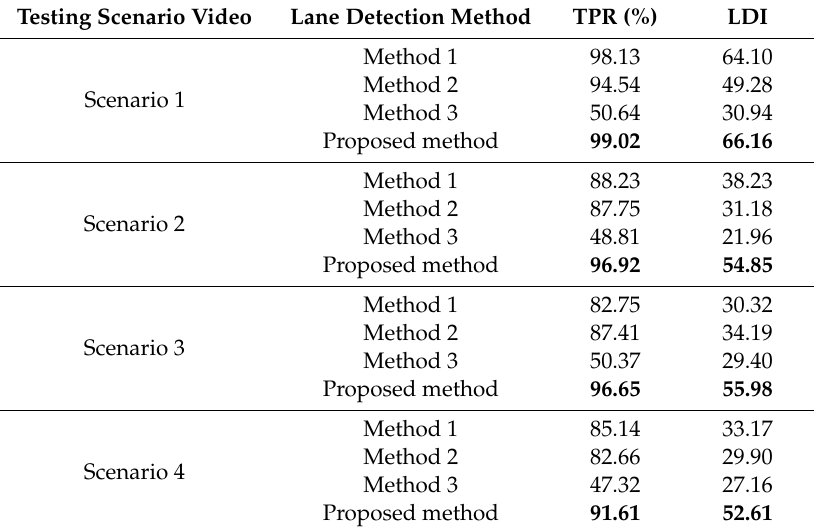
Table 7. Comparative results of lane detection